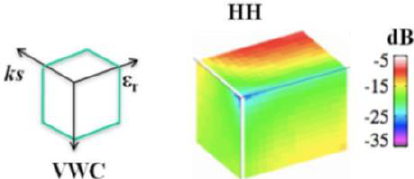
Figure 1. Example of a three-dimensional lookup table (called datacube) of the forward scattering model to use during the inversion [25].